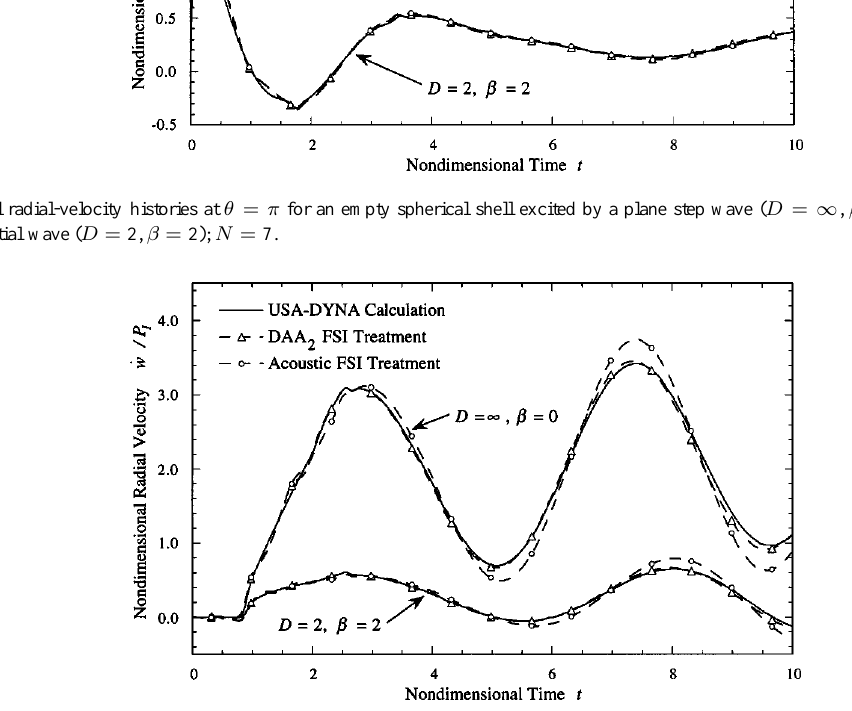
Fig. 12. Shell radial-velocity histories at (cid:18) = 0 for an empty spherical shell excited by a plane step wave ( D = 1 , (cid:12) = 0) and a spherical step-exponential wave ( D = 2, (cid:12) = 2); N =